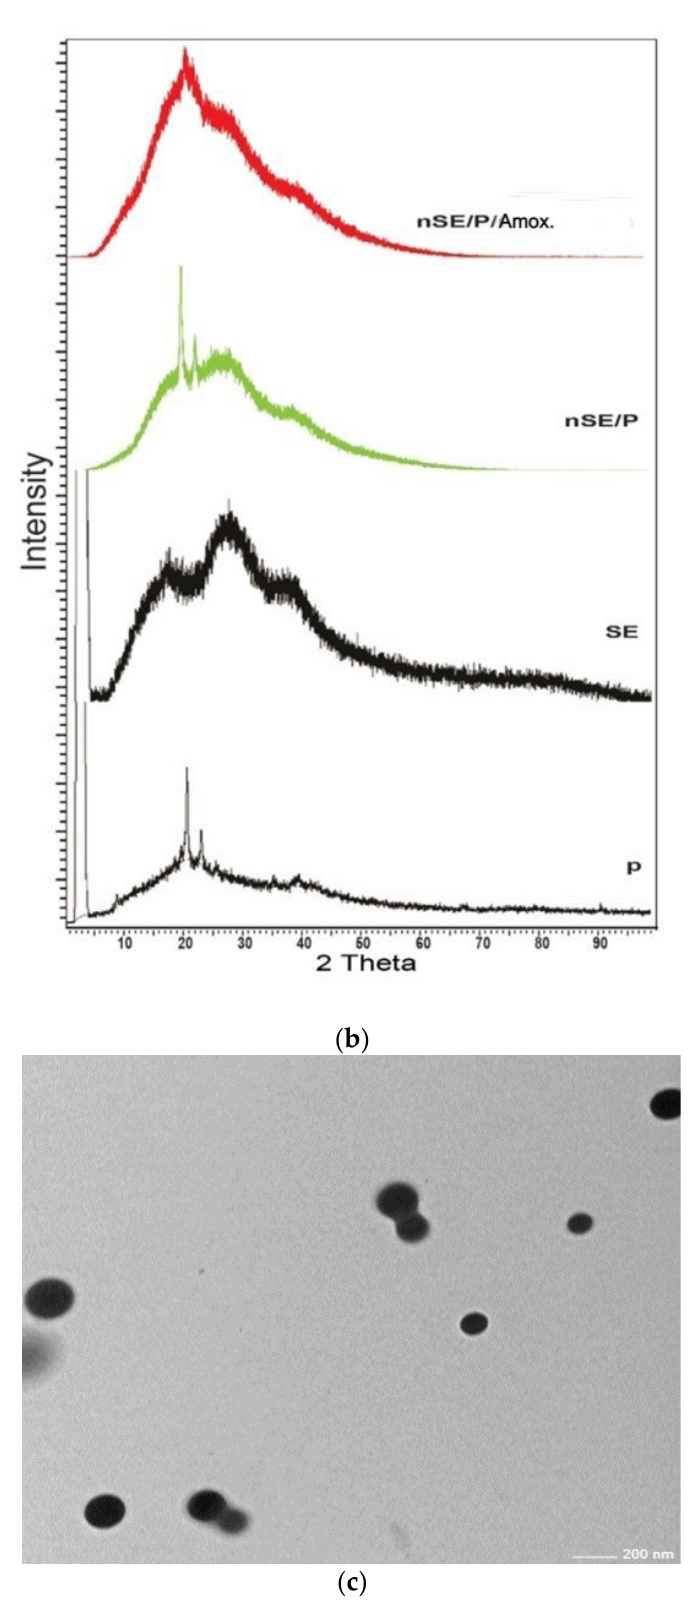
Figure 4. Fourier transform infrared spectra ( a ), XRD of pure sericin, propolis, nSE/P and nSE/P/AMX ( b ) and transmission electron micrograph of sericin/propolis/AMX polymeric nanopar- ticles ( c ).